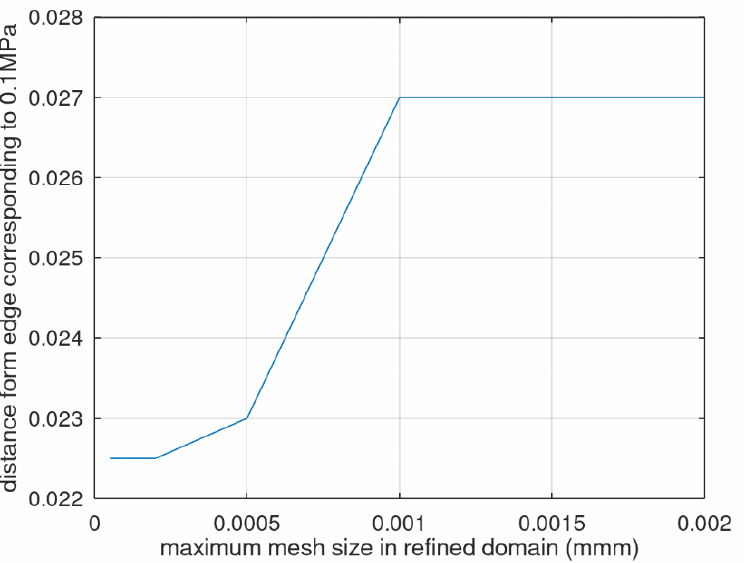
Figure 11. Evolution of the distance from the edge that corresponds to a Von Mises stress equal to 0.1 MPa when changing the maximum cell size in the domain close to the edge.